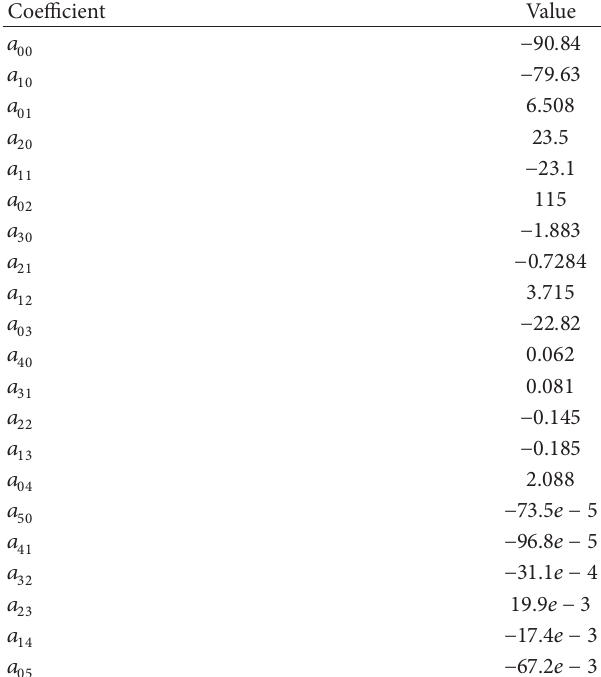
Figure 4: Muscle force function approximation using fifth-order polynomial. Blue circles correspond to experimental data given in [18]. Even though it is not shown in the figure, the force approximator used saturation function at its output to limit the force into (0, 1200)N interval. Table 1: Values of polynomial coefficients used for approximation of nonlinear spring term (all other coefficients were equal to